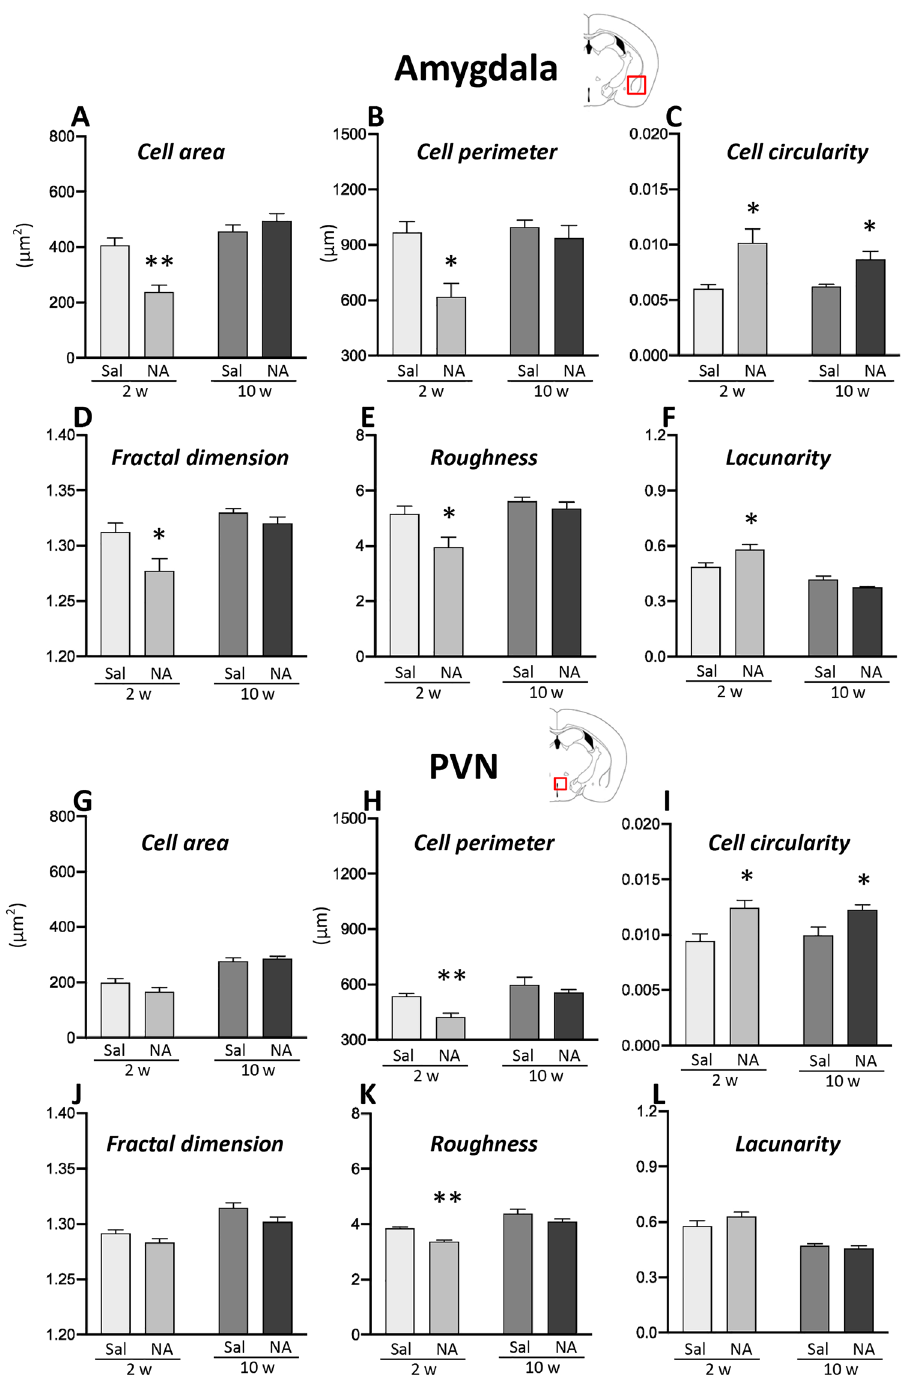
Figure 8. Morphological parameters of microglial cells sampled from the amygdala and PVN of rats subjected to NA-induced neuroinflammation. Rats ICV-injected with saline (Sal) or with neuraminidase (NA) were sacrificed 2 weeks (2w) or 10 weeks (10w) after the ICV injection. Histological sections obtained from their brains were immunostained for IBA1. Images of individual microglial cells located in the amygdala or the PVN were processed to measure morphological parameters. Student’s t-test was performed in order to check the influence of treatment (Sal versus NA) on microglia morphology sampled from different experimental groups at both time points. Here are shown only some of the parameters measured (other parameters available in Supplementary material S1): cell area ( A , G ), cell perimeter ( B , H ), cell circularity ( C , I ), fractal dimension ( D , J ), roughness ( E , K ) and lacunarity ( F , L ). The bars in histograms represent the mean value ± SEM of n = 50–57 cells for amygdala ( A – F ) and n = 40–60 cells for PVN ( G – L ) per experimental group. Morphological differences between NA and saline treated groups are more evident in amygdala 2 weeks after the ICV-injection, while after 10 weeks most parameters (except for C, cell circularity ) are similar in both groups. In PVN differences between NA and saline groups are scarce (see H , I and K , cell perimeter , cell circularity and roughness ). * p < 0.05; ** p <